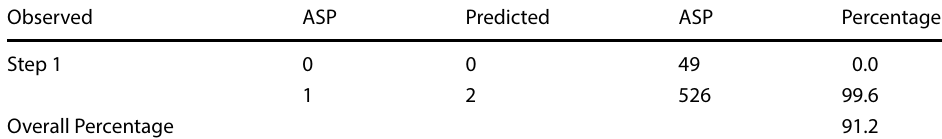
Table 11 Classification table